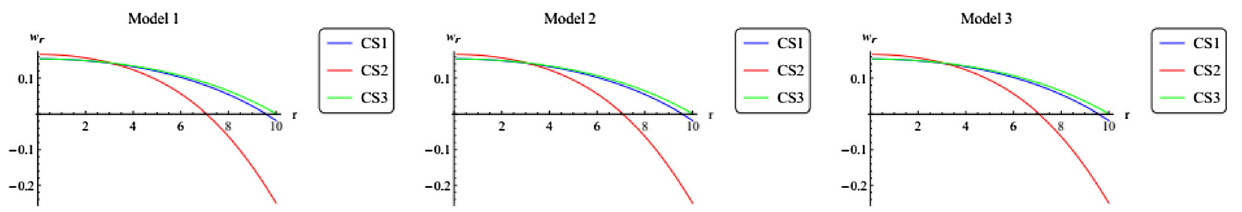
Fig. 13 Variations of radial EoS parameter for different viable f ( G ) gravity models ∼ 1 / 3 and v 2 In our case, v 2 is plotted in Fig. 11, which sr sr ≤ 1 and 0 ≤ v 2 ≤ 1 which is obey the condition 0 ≤ v 2 sr st the indication of causality preservation within these charged compact